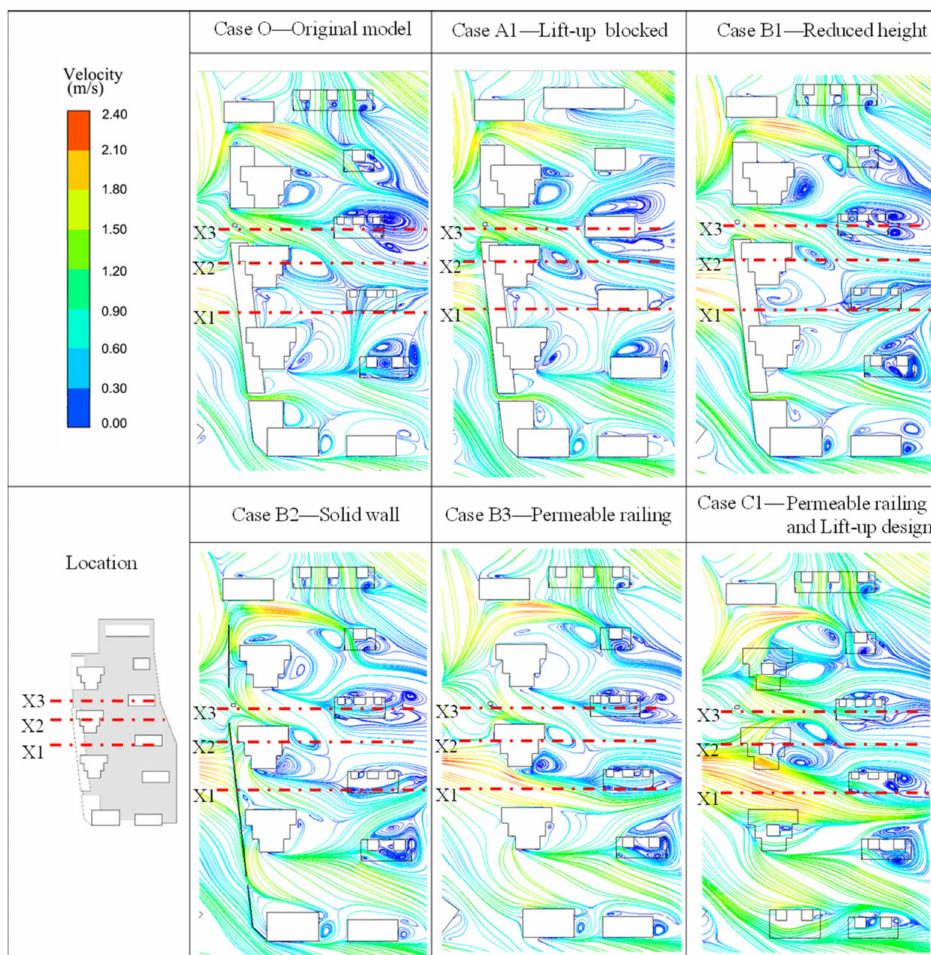
Figure 14. Streamline patterns of X1, X2, and X3 at pedestrian height for the six